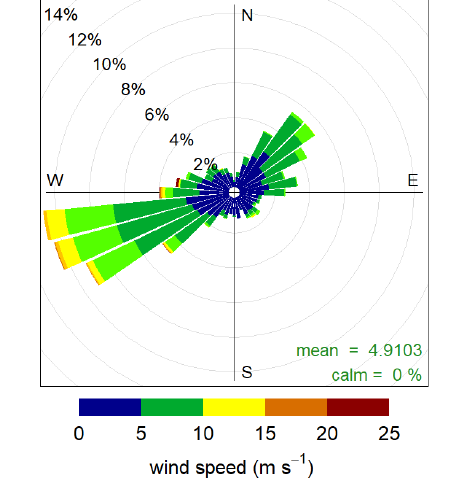
Figure 1. Wind rose for the Beromünster station for the duration of the measurement campaign and based on 10min average wind observations. The frequencies of wind from different directions are given as percentage, and wind speeds are given in coloured intervals in metres per second (hereafter ms − 1